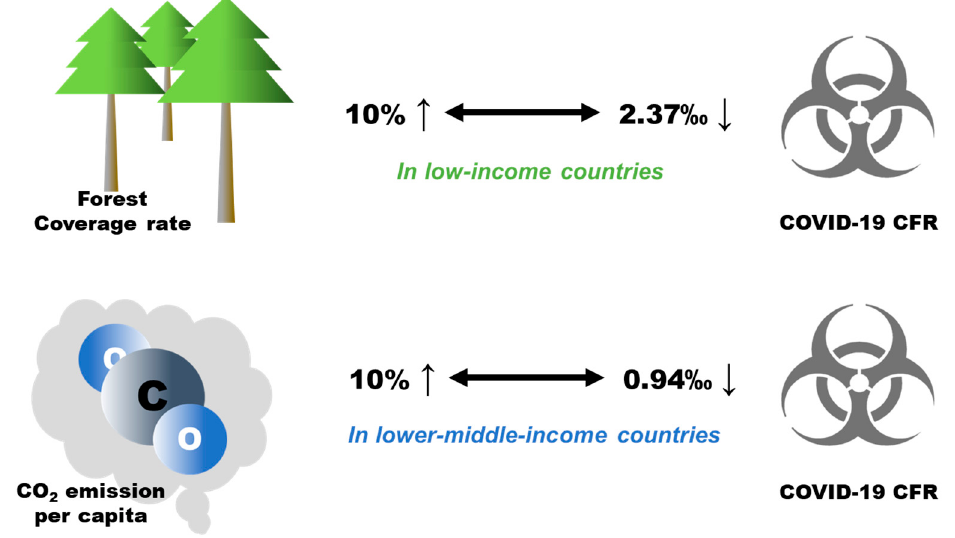
Figure 4. The stratified analyses on associations between forest coverage rate, CO 2 emission per capita, and COVID-19 CFR.